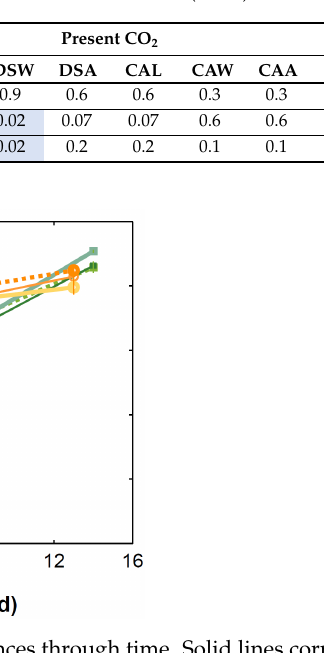
Table 2. Enzymatic activities at the start (0) and after 4 and 13/14 days of incubation, under present and future CO 2 concentrations.